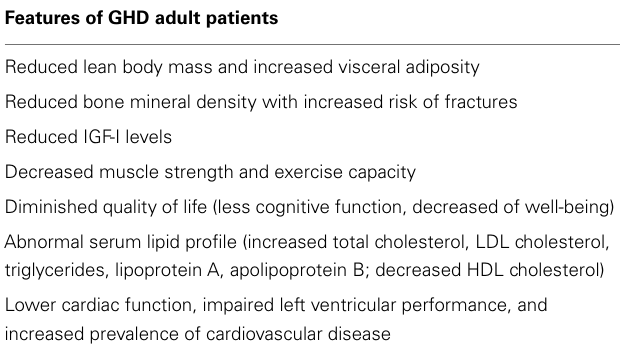
Table 1 | Features of growth hormone deficiency (GHD) in adult